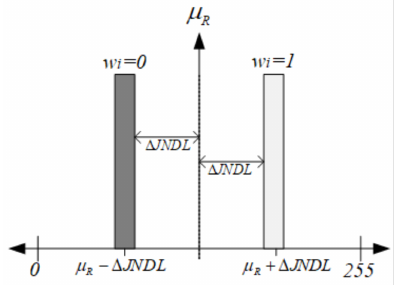
Figure 5. Histogram of the watermarked region by Equation